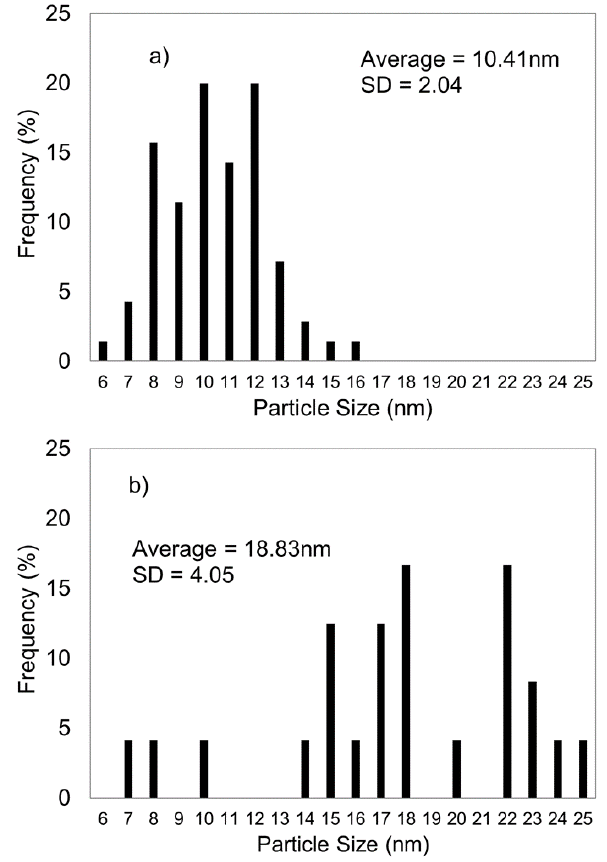
Figure 5. Histograms of the particle size distribution determined by TEM. ( a ) CuO / ZnO / Al 2 O 3 catalyst prepared via oxalate gel-co-precipitation; ( b ) CuO / ZnO / Al 2 O 3 catalysts prepared via Na 2 CO 3 co-precipitation. Cu / Zn / Al (molar) = 35 / 35 /